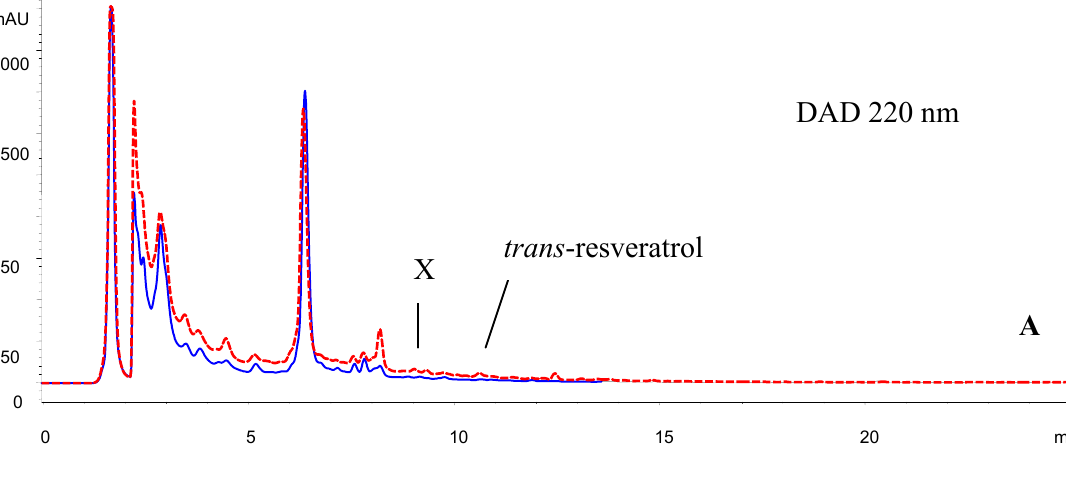
Figure 3. HPLC chromatograms of the extracts of the Alibernet variety (susceptible) leaves. Comparison of healthy leaves (blue line) and leaves infected by Plasmopara viticola (red dashed line). ( A ) Chromatogram of the extract at 220 nm. ( B ) The same chromatogram at 315 nm. ( C ) Chromatogram of the extract using FLD detector. Compound X is 2,4,6-trihydroxyphenanthrene-2- O -glucoside. ( D ) Comparison of the susceptible infected variety Alibernet (dashed line) and resistant infected variety Cerason (solid